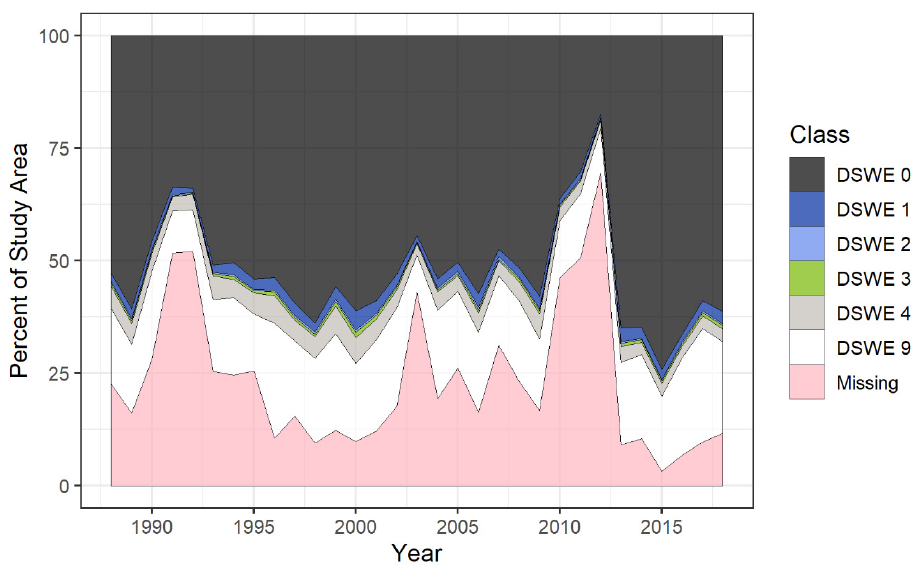
Figure 2. DSWE classes aggregated by year as a proportion of the study area. The data distribution illustrates the influence of clouds (DSWE class 9) and gaps in the Landsat data time series (“Missing”). Only those months with a high proportion of usable data across the study area (i.e., >20% clear of clouds and missing data) were retained for subsequent analyses, and 2012 was removed entirely.